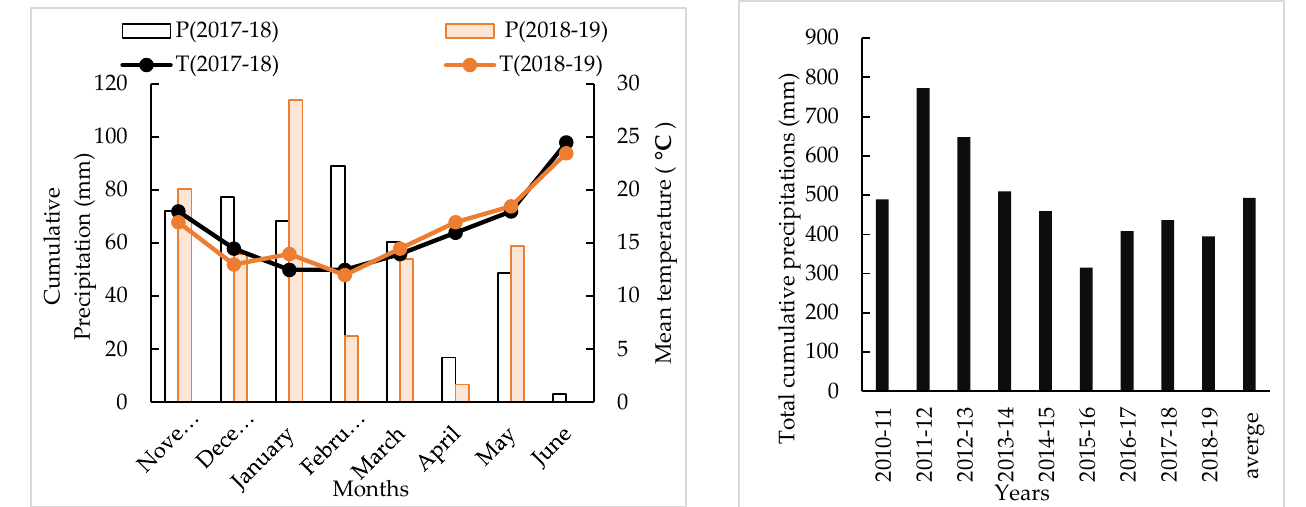
Figure 2. Left graph: Total monthly precipitations (mm) and mean temperatures (°C) during the